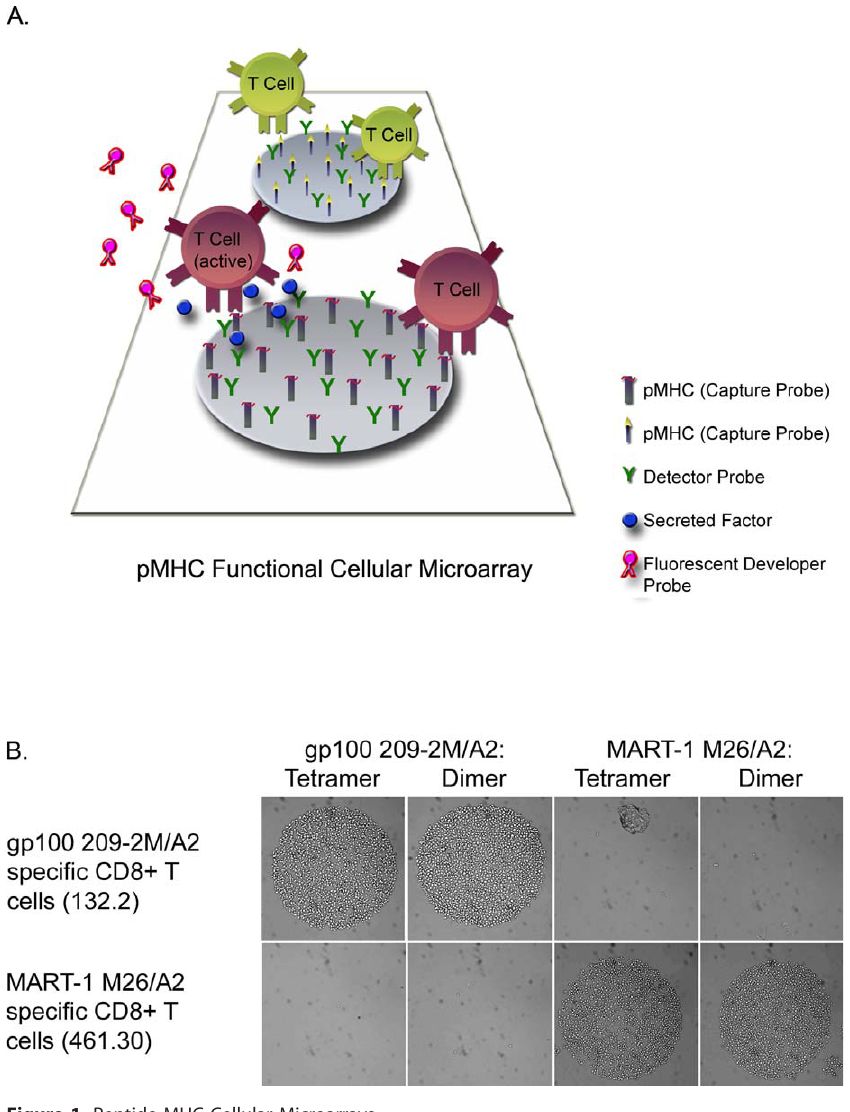
Figure 1. Peptide-MHC Cellular Microarrays (A) A functional pMHC microarray diagram illustrating the array format. An array of spots containing different capture probes (pMHC molecules) cospotted with detector probes, which are antibodies against potentially secreted factors. Antigen-specific T cells are captured by recognition of printed pMHC, and may become activated. Subsequent secretion of specific factors is captured by the printed detector probes. The presence of those factors is detected by labeled secondary antibodies (developer probes). (B) Specificity of pMHC T cell capture is peptide-specific. Human CD8 þ lymphocyte clones 132.2 and 461.30 were incubated on duplicate microarrays, which included gp100-2M/HLA-A2.1 and MART-1 M26/HLA-A2.1 tetramer and dimer spots. 2M-specific 132.2 cells were exclusively captured by gp100 spots, and M26-specific 461.30 binding was restricted to MART-1 spots. Binding efficiency to pMHC tetramer or dimer of a given specificity was similar. DOI: 10.1371/journal.pmed.0020265.g001